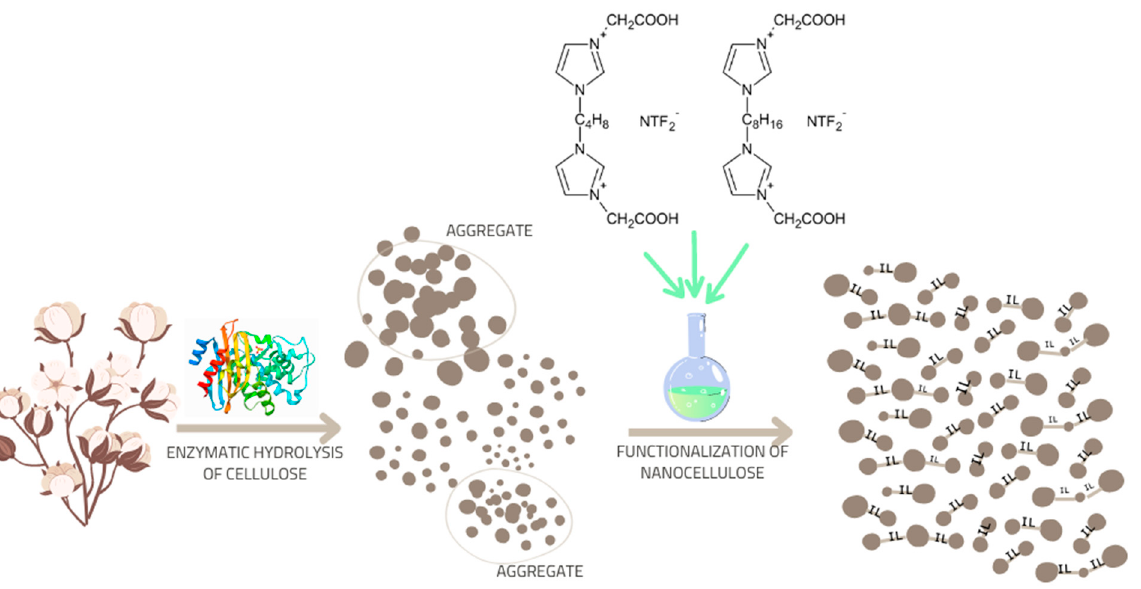
Figure 4. Mechanism of action of dimeric imidazolium ionic liquids against the applied cellulosic material.